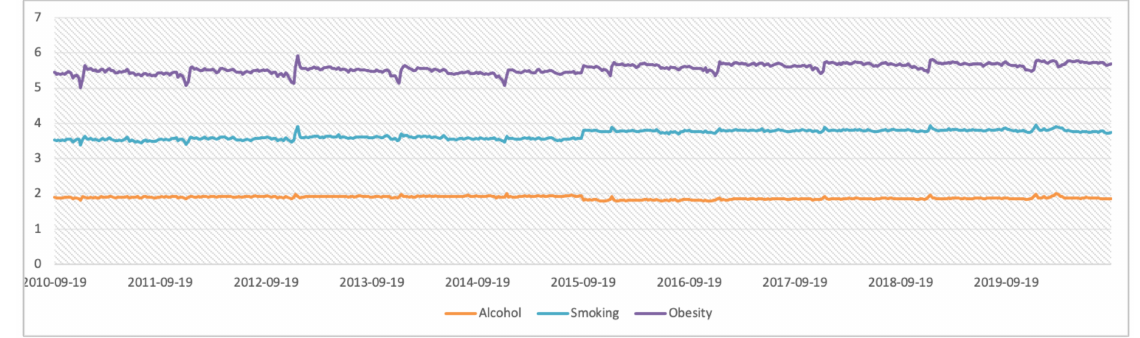
Figure 2. Time series of Google search queries. Search fractions are rescaled between 0 and 100 by the internal processes of Google Trends upon download, although a logarithmic scale was used to represent the results. Note: Google Trends had two methodological improvements (namely, on 1 January 2011, improvement in geographic allocation, and on 1 January 2016, improvement in data collection). Data source: Google Trends (https://www.google.com/trends, accessed on 20 September 2020). The chart legend indicates the colors for each topic.